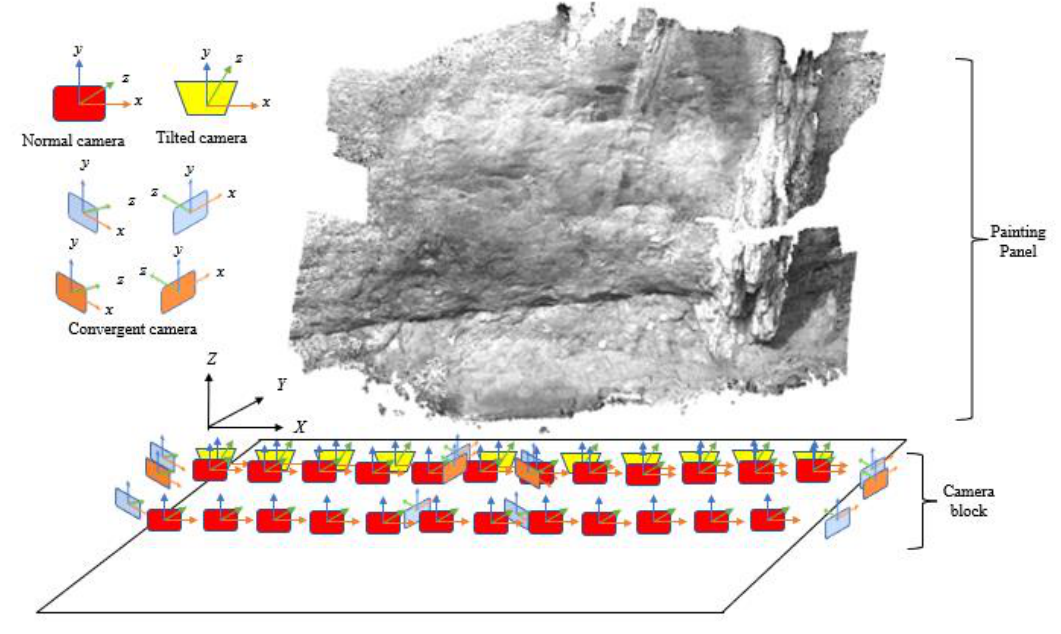
Figure 3. Configuration for data